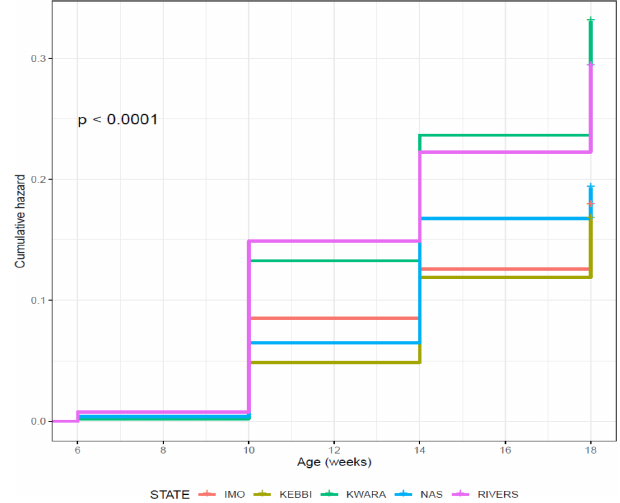
Figure 7. Effect of agroecologies on overall on-farm cumulative hazard of birds (male and female) during growing phase in ACGG Nigeria project zones (6–18 weeks)